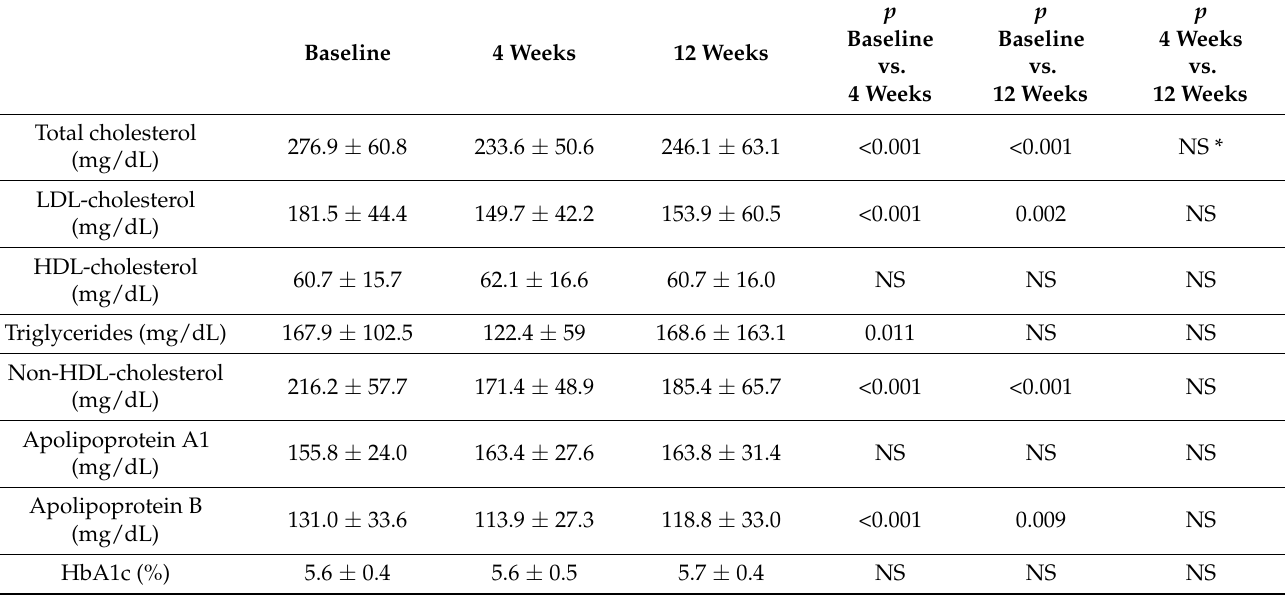
Table 2. Clinical and anthropometric characteristics of the study population at baseline, and after four and 12 weeks .